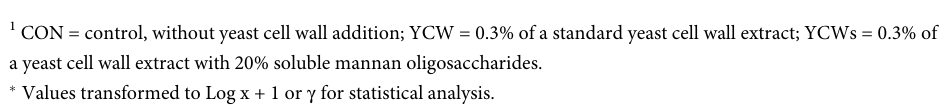
with fermentation end-products formation; these data indicate that the solubility of the carbo- hydrate fractions of the yeast cell wall may be a key factor for product interaction with the gut microbiota.